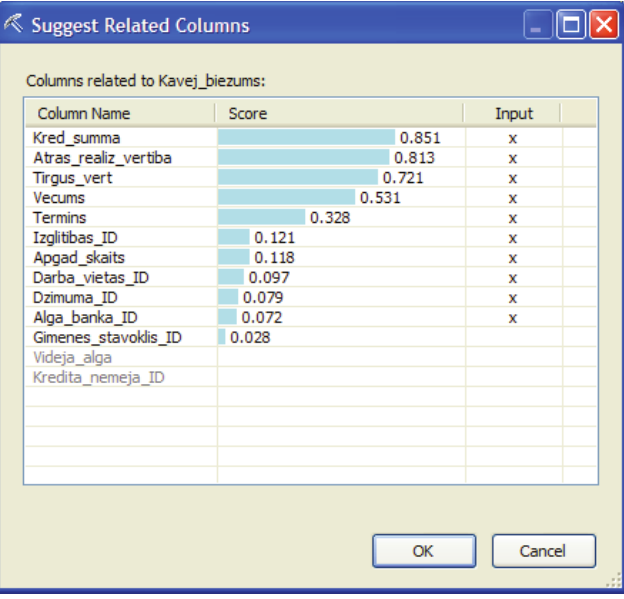
Fig. 2. Score calculation results of influence of different factors using Micro - soft Analysis